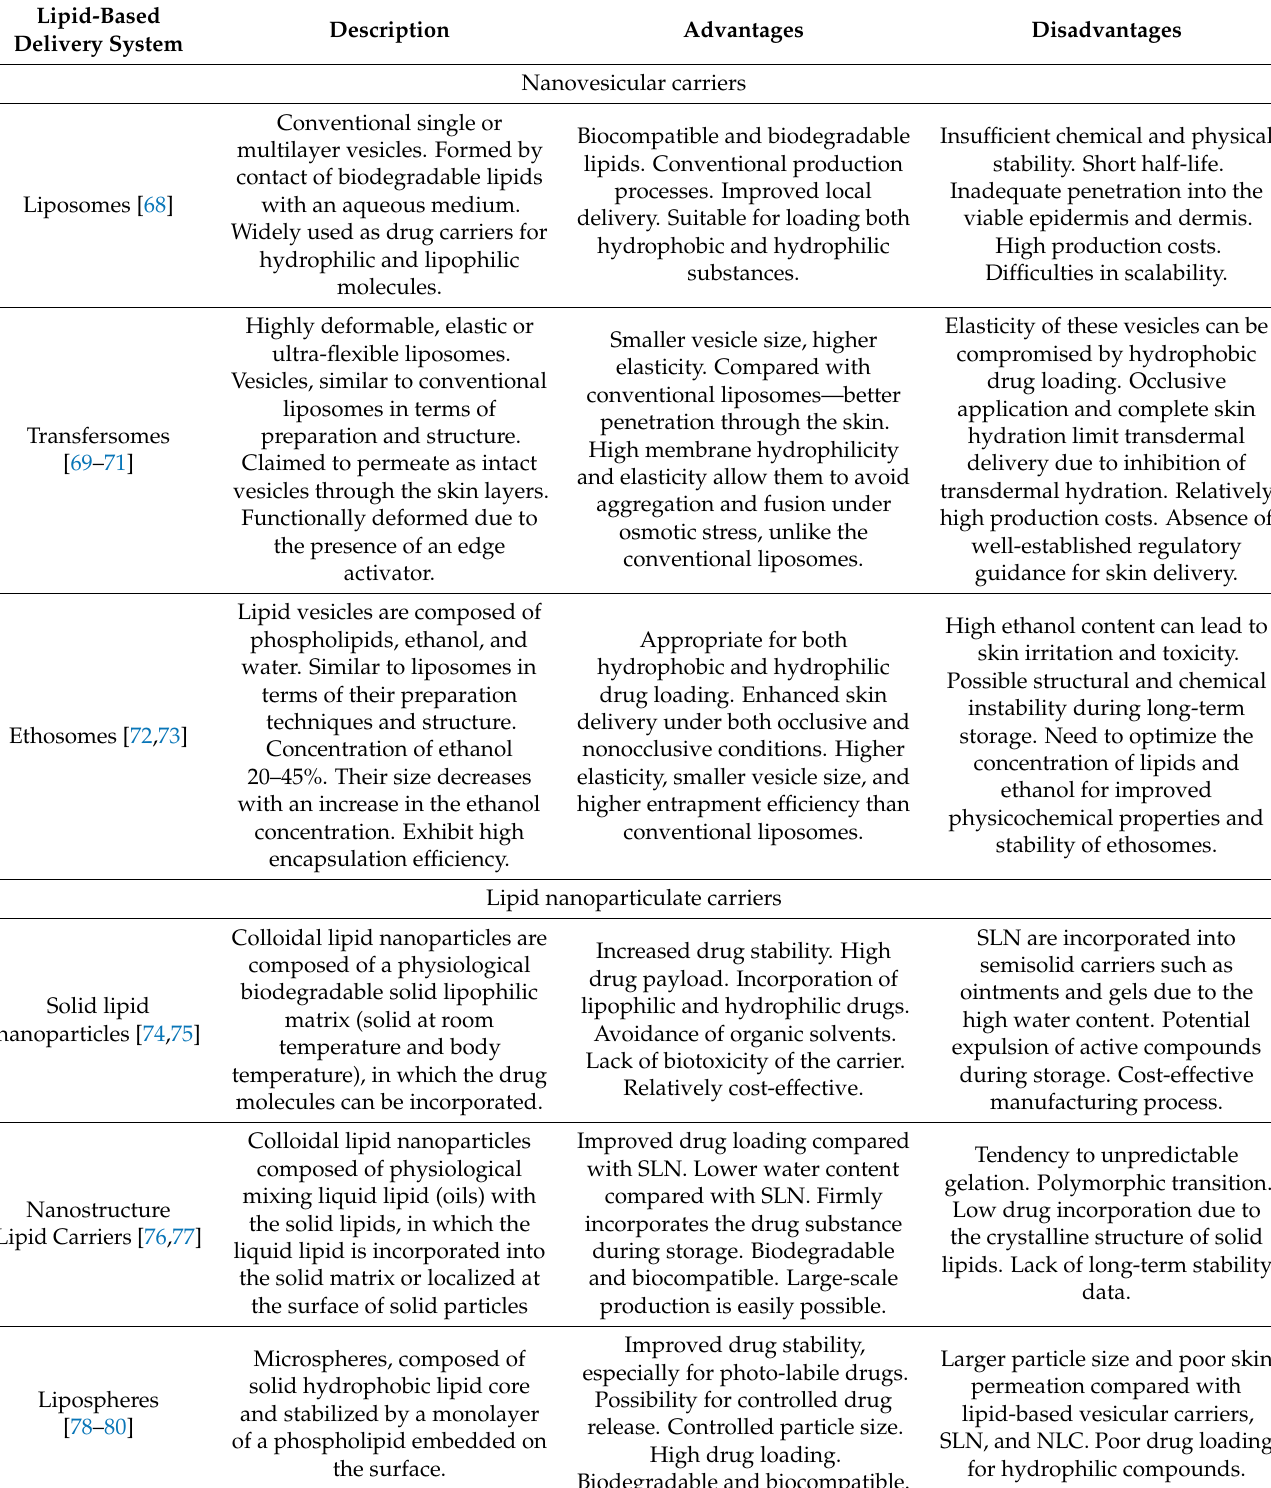
Table 2. Presentation of some lipid-based delivery